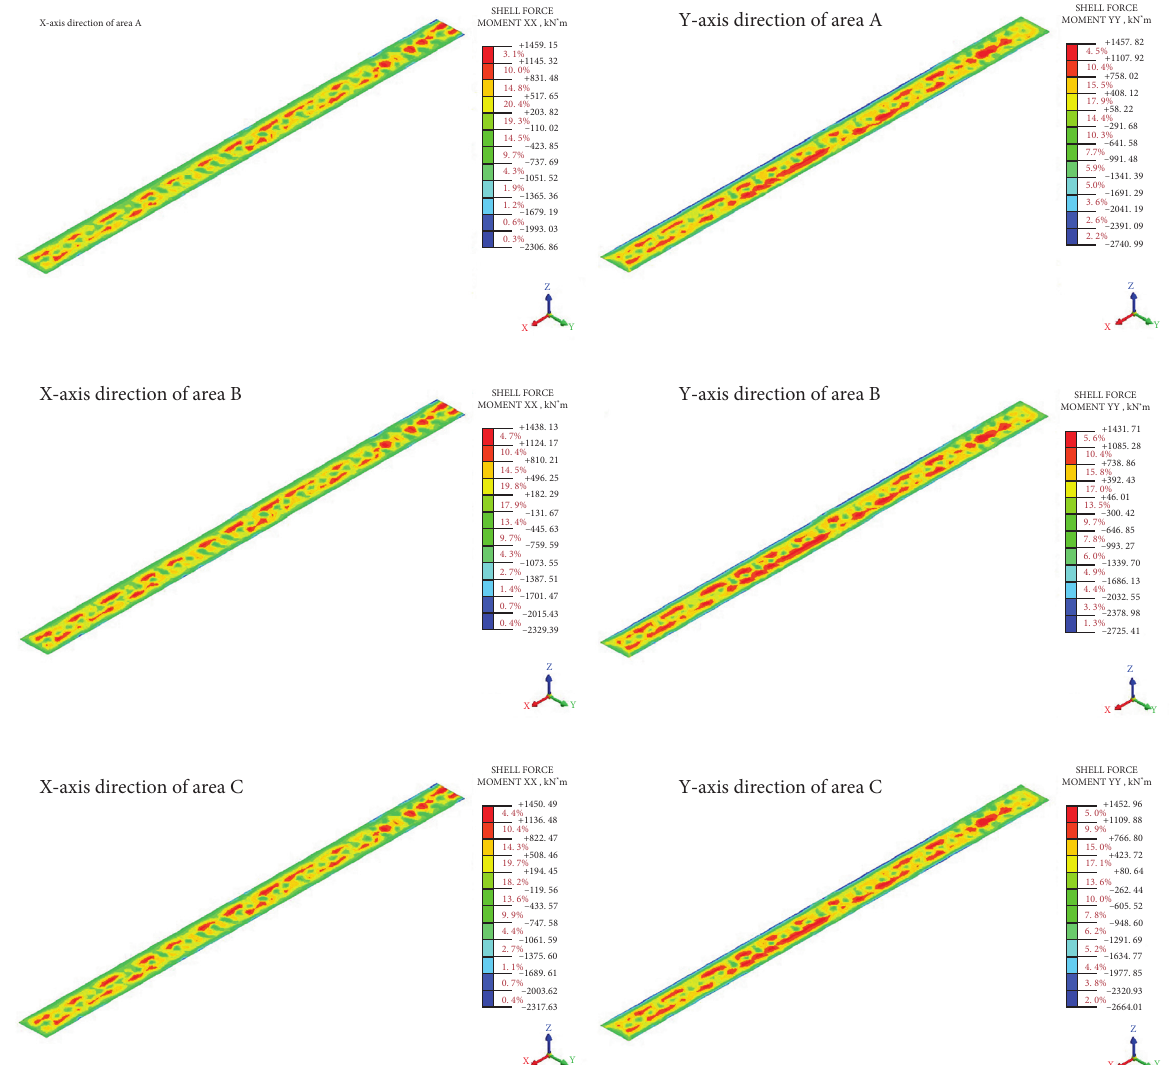
Figure 5: Distribution of bending moments in the X and Y axes from the foundation pit excavation to the station bottom plate in each